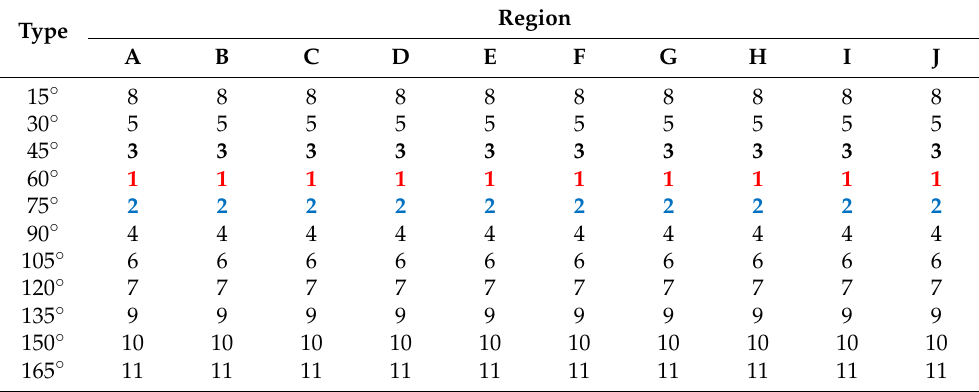
Table 14. Ranks of optimized installation angles for a kinetic louver in winter.